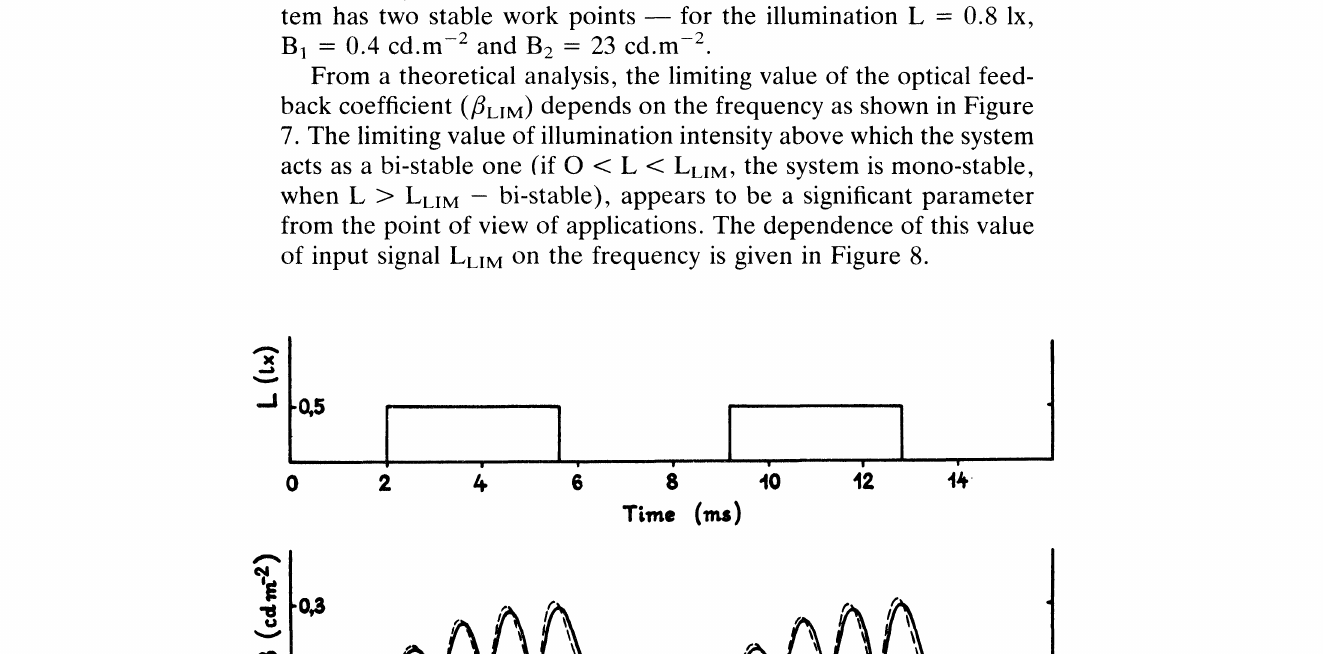
FIGURE 5 Luminance vs. time for a frequency of 500 Hz and an amplitude of 280 V ( experimental results, values calculated using the theoretical